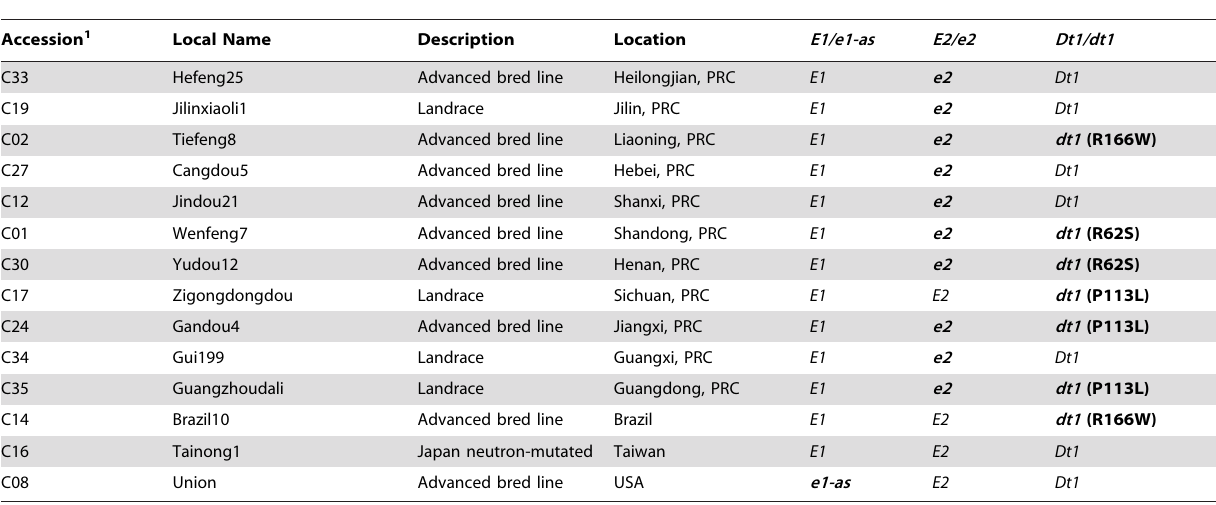
Table 4. Maturity and growth determinate genotypes for cultivated